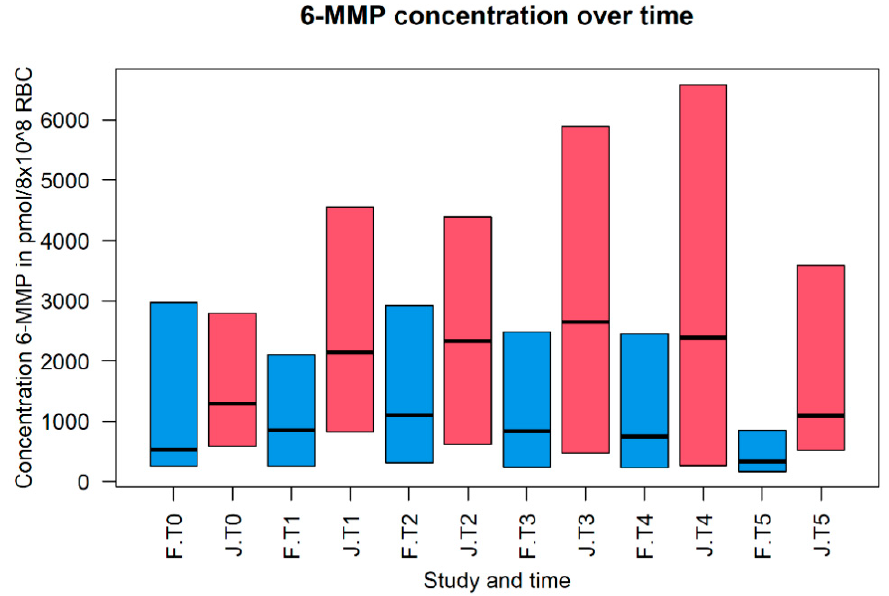
Figure 3. The concentration of 6-methylmercaptopurine (6-MMP) during the different states of pregnancy. Concentrations of 6-MMP are expressed in pmol × 10 8 Red Blood Cell (RBC) count on the y -axis (median with corresponding 25th and 75th percentile). The different states of pregnancy per study are shown on the x -axis. The different states are expressed as pre-pregnancy (T0), trimesters one until three (T1, T2 and T3), delivery (T4) and postnatal (T5). F, the blue bar, represents the study of Flanagan et al. (2021) and J, the red bar, represents the study of Jharap et al. (2013)